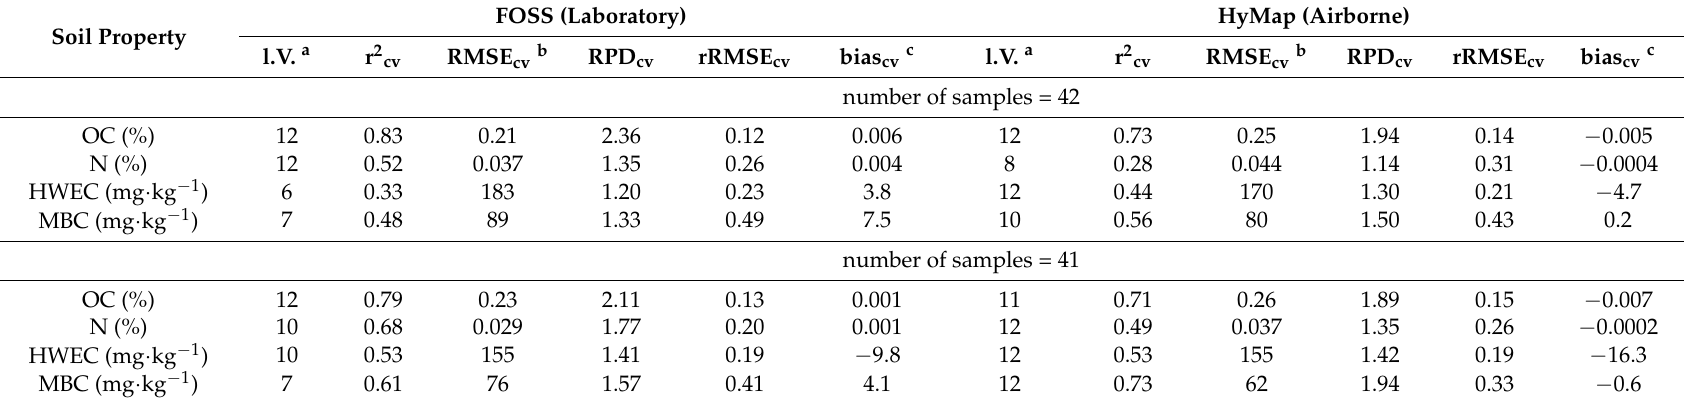
Table 3. Statistics of estimates from FOSS and HyMap spectra using PLS regression with all 125 spectral variables (LOO cross-validated results).